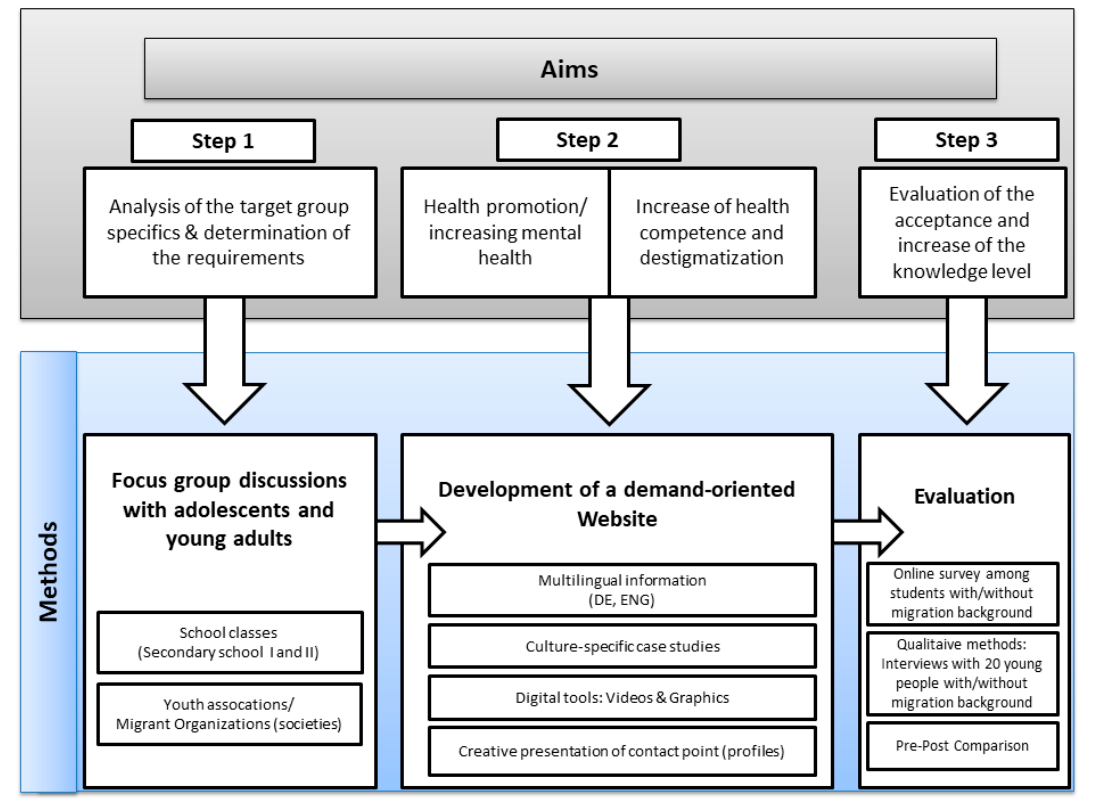
Figure 1. Overview about steps, aims, and methods of the research project.